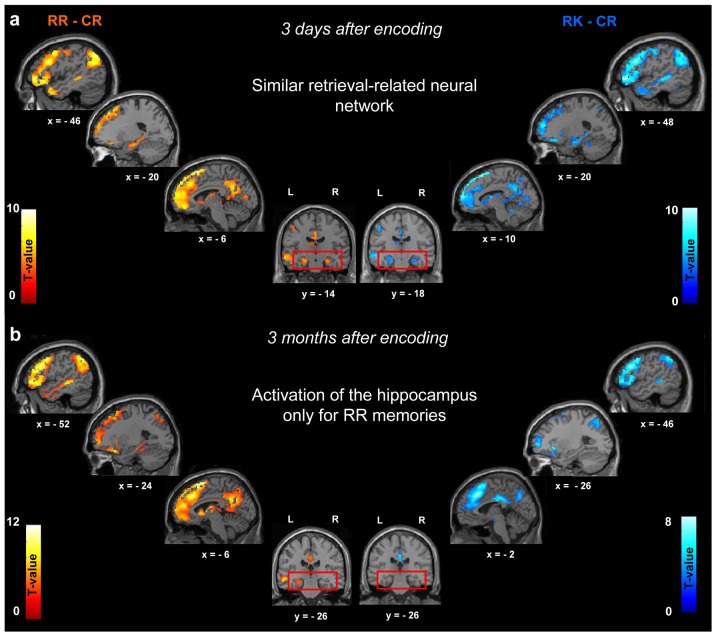
Brains areas subserving retrieval of consistently episodic (RR responses) or initially episodic and later semantic (RK responses) memories compared to correct rejections (CR), 3 days (a) and 3 months (b) after encoding.Activations are displayed at p<0.001 (uncorrected) on sagittal or coronal sections of the MNI template. Note that the right hippocampal activation did not survive correction for multiple comparisons.